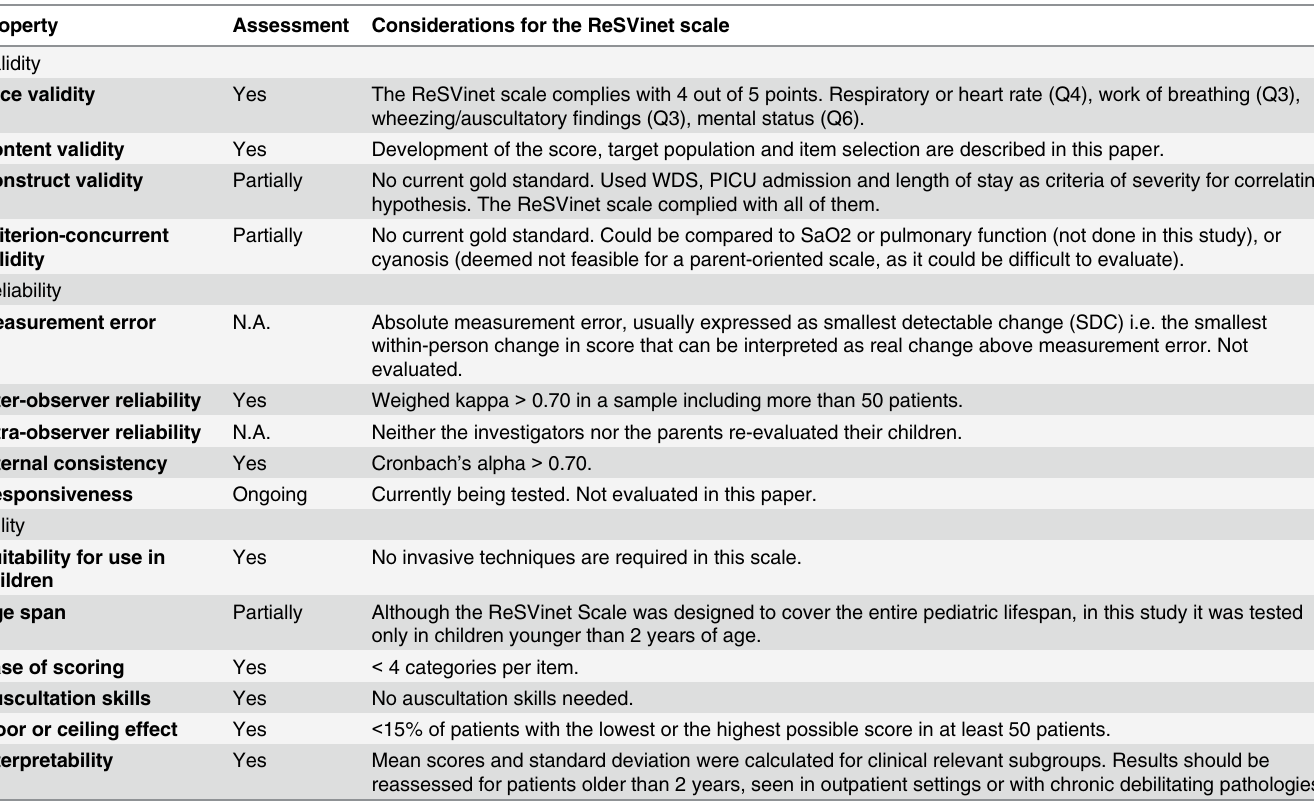
Table 5. Check-list of the characteristics of the ReSVinet scale according to the desired properties of a clinical scale validated for use in infants with acute respiratory infections * . The “ considerations ” column explains whether the ReSVinet scale meets the requirement. N.A. = not assessed. Property Assessment Considerations for the ReSVinet